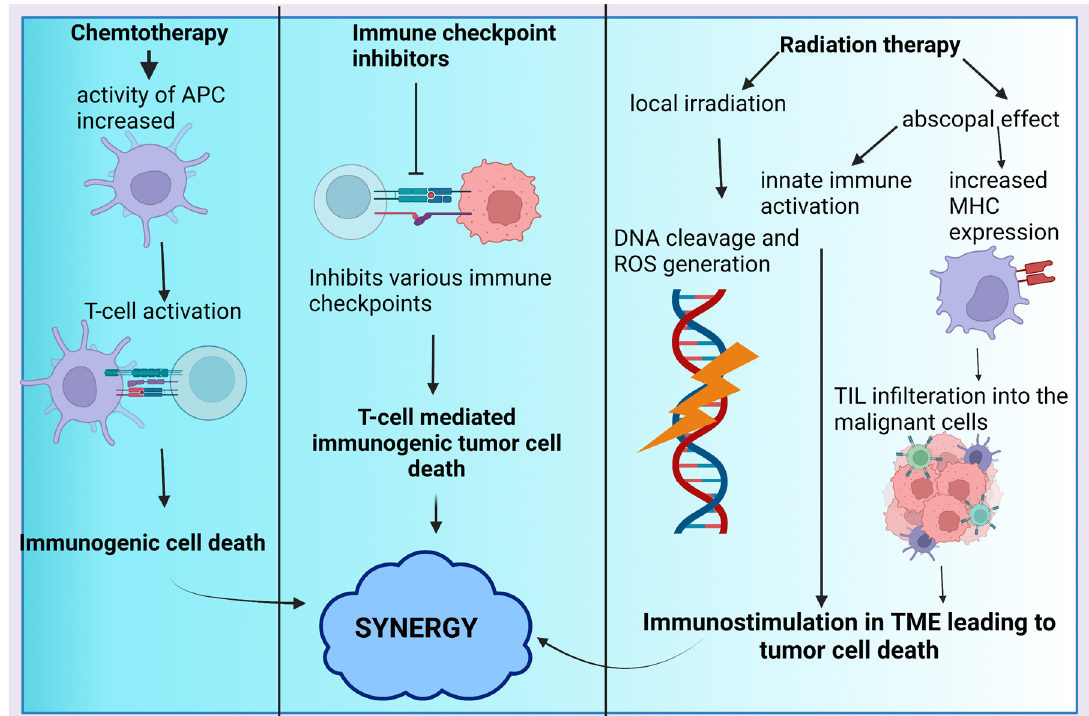
Figure 3. The rationale of combining ICIs with radiation and chemotherapy. This shows the influ- ence of the immune system on the mechanism of conventional therapies. Though immune mediated tumor death is not the major mechanism for the antitumor effects of these conventional therapies, there is some amount of involvement of immune mediated mechanisms. This provides a rationale for combining immunotherapy with chemotherapy and radiation, as this might provide synergistic effects. Abbreviations: APC: antigen presenting cells, DNA: deoxy-ribo-nucleic acid, MHC: